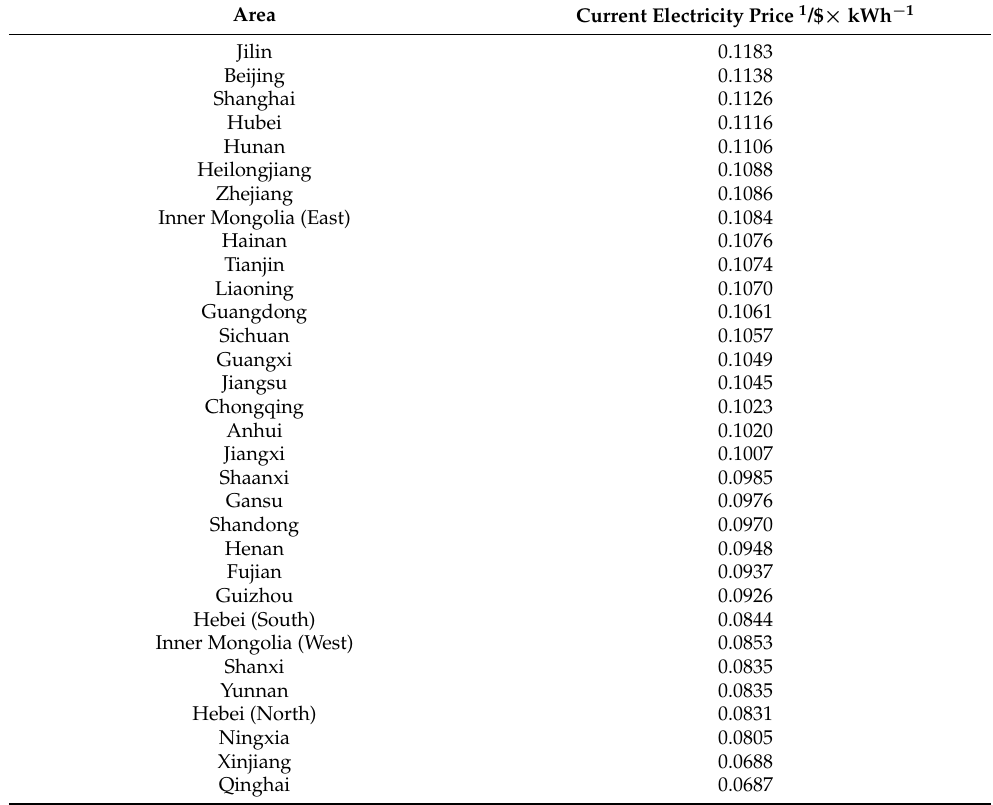
Table A2. Current electricity price for general industrial and commercial use in various